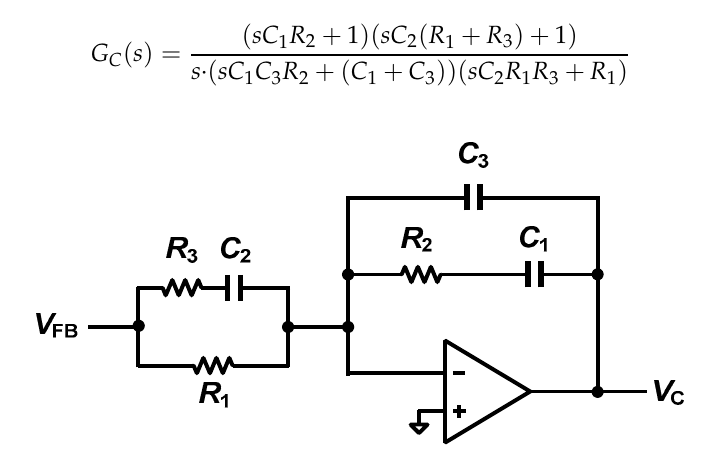
Figure 8. Type-III compensator.